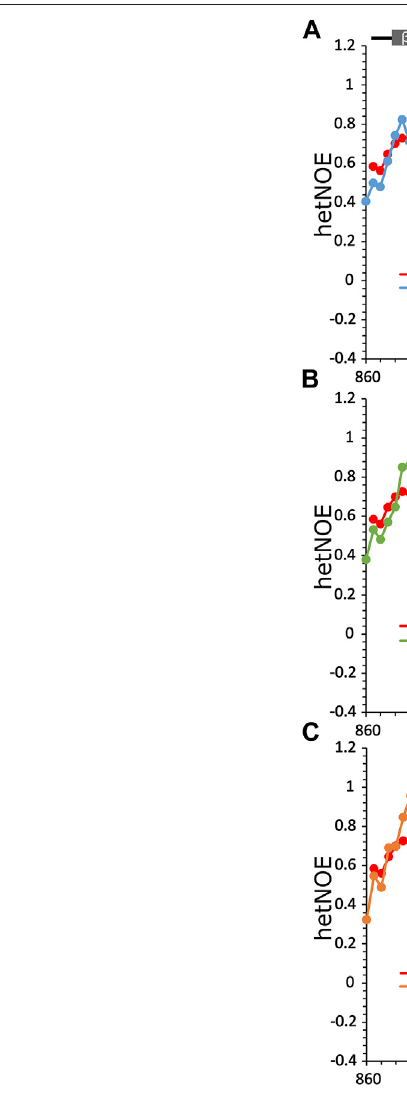
FIGURE 3 | Heteronuclear 1 H- 15 N NOEs data of CW bound to histone-mimicking peptides. (A) CW with H3K4me1 (blue circles); (B) CW with H3K4me2 peptide (green circles); and (C) CW with H3K4me3 peptide (orange circles). The data in each panel are overlaid with unbound CW (red circles). Secondary structure of CW is indicated at the top of the panels. All samples were dissolved in NMR buffer (20 mM phosphate buffer pH 6.4, 50 mM NaCl, and 1 mM DTT) with 10% D 2 O at 200 µM concentration of CW. The CW-to-peptide ratios were 1:4 for H3K4me1, 1:6 for H3K4me2, and 1:10 for